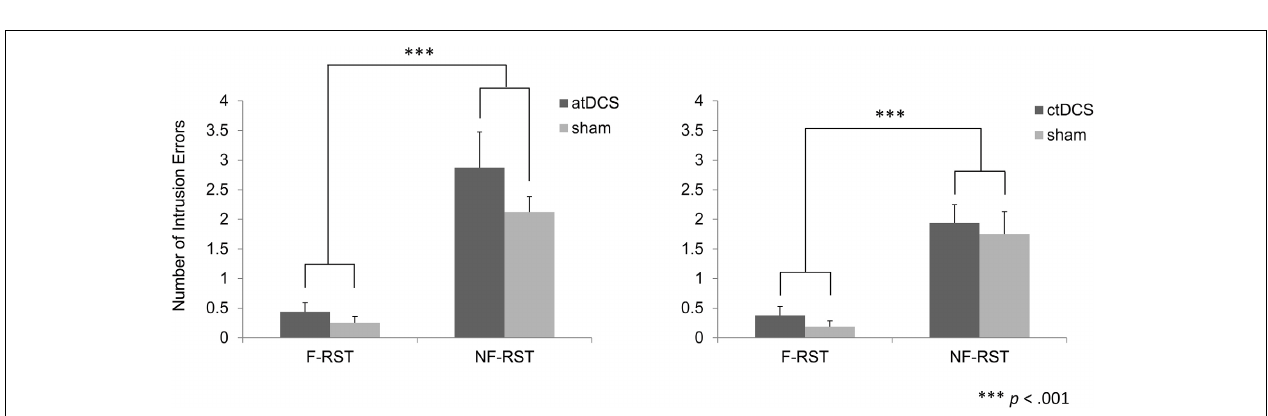
( Figure 5 ). Such a difference was not observed for focus